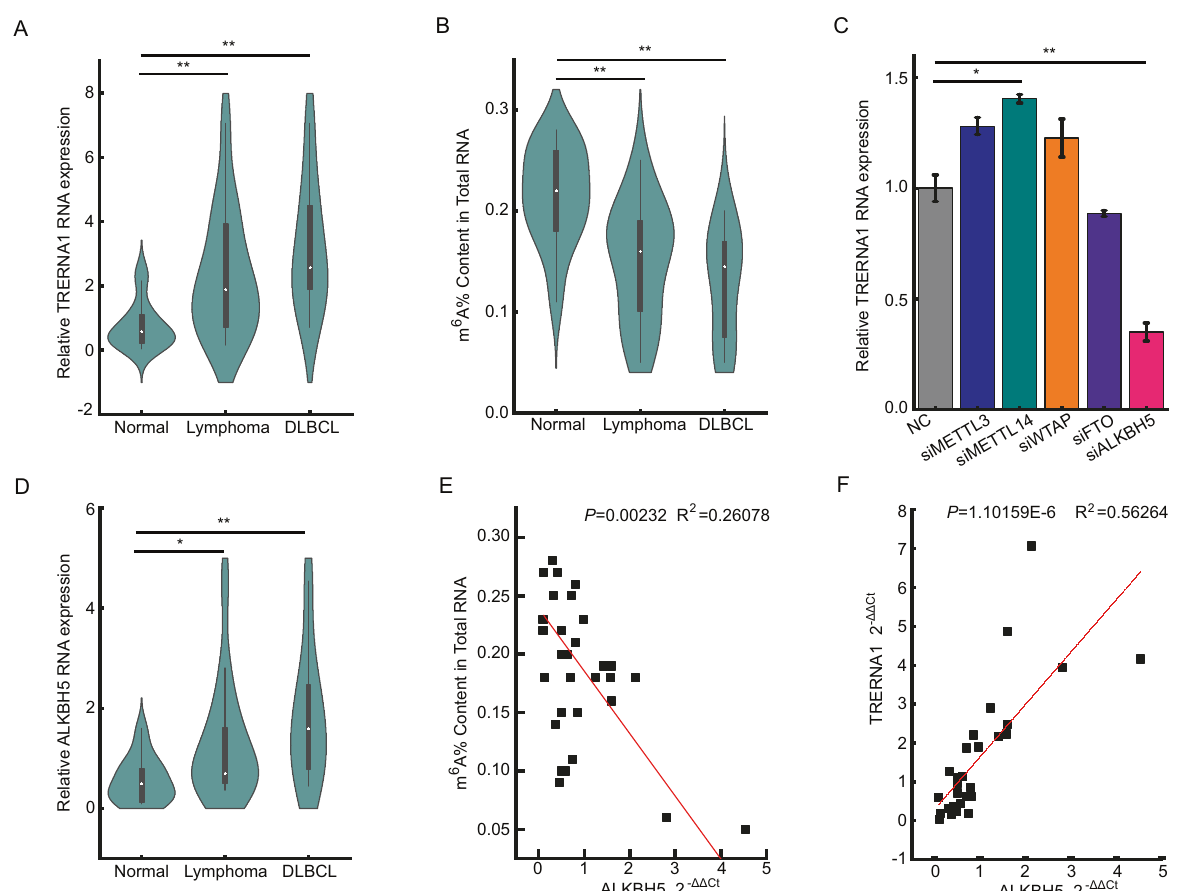
Fig. 1 TRERNA1 is highly expressed in DLBCL and is associated with m 6 A modi fi cation. A TRERNA1 RNA expression in DLBCL tissues and normal lymph node hyperplasia tissues. B The m 6 A contents of total RNA from 15 lymphoma tissues (including 8 cases of diffuse large B cell lymphoma) and 15 normal lymph node hyperplasia tissues. C TRERNA1 expression levels were measured by RT-qPCR after transfection with different m 6 A modi fi cation-associated genes. D The ALKBH5 expression in DLBCL tissues and normal lymph node hyperplasia tissues. E The correlation between ALKBH5 levels and m 6 A in DLBCL. F Scatter plot between ALKBH5 and TRERNA1 in DLBCL. The data are presented as the mean ± SD values; n = 3. * P < 0.05, ** P < m 6 A modi fi cation of TRERNA1 epigenetically silences p21 p21 expression by interacting with EZH2. RNA immunoprecipita- tion assay results con fi rmed that TRERNA1 could directly bind to EZH2 (Fig. 5E, F), demonstrating a speci fi c association between EZH2 and TRERNA1. Next, we conducted chromatin immunopre- cipitation (ChIP) assays to evaluate the effects of TRERNA1 on EZH2 binding and H3K27me3 modi fi cation of the p21 gene promoter in SU-DHL4 cells. As expected, TRERNA1 knockdown decreased the EZH2 enrichment and H3K27me3 modi fi cation of the p21 promoter compared to that observed in the control (Fig. 5G, H and Fig. S3A, B). SUZ12 is a key component of PRC2, we also found that TRERNA1 could interact with SUZ12 to repress p21 expression (Fig. S4). To assess whether ALKBH5 was responsible for the observed EZH2- mediated expression of p21, we transfected siALKBH5 or ALKBH5 overexpression constructs into OCI-Ly3 cells. Overexpressed ALKBH5 further inhibited p21 protein expression (Fig. 5I). We further determined whether p21 functioned as a key downstream in TRERNA1-involved DLBCL cell proliferation. As shown in Fig. S5A, we found that p21 downregulation signi fi cantly reversed the inhibition of cell proliferation induced by silencing TRERNA1. Moreover, upregulated p21 obviously abolished the proliferation induced by TRERNA1 overexpression. There is a negative relation- ship between TRERNA1 and p21 expression levels in our lymphoma tissues (Fig. S5B). These results indicated that low levels of m 6 A modi fi cation in TRERNA1 can epigenetically silence p21 expression by interacting with EZH2 to promote cell proliferation.